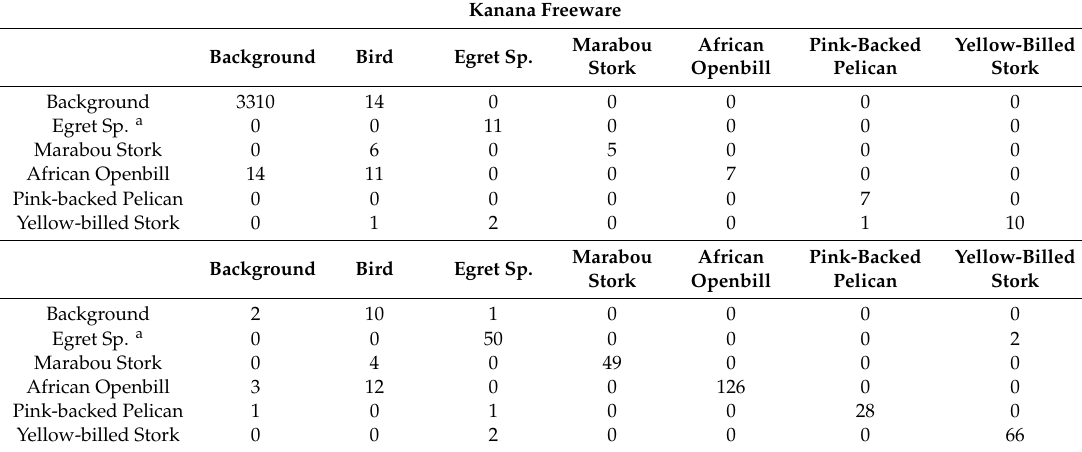
Table 4. Results for the freeware and payware used in development of semi-automated methods for the Kanana colony, showing the secondary error matrix after correcting for probabilities, and the final error matrix after correcting for area, where rows are the test data and columns are the predicted